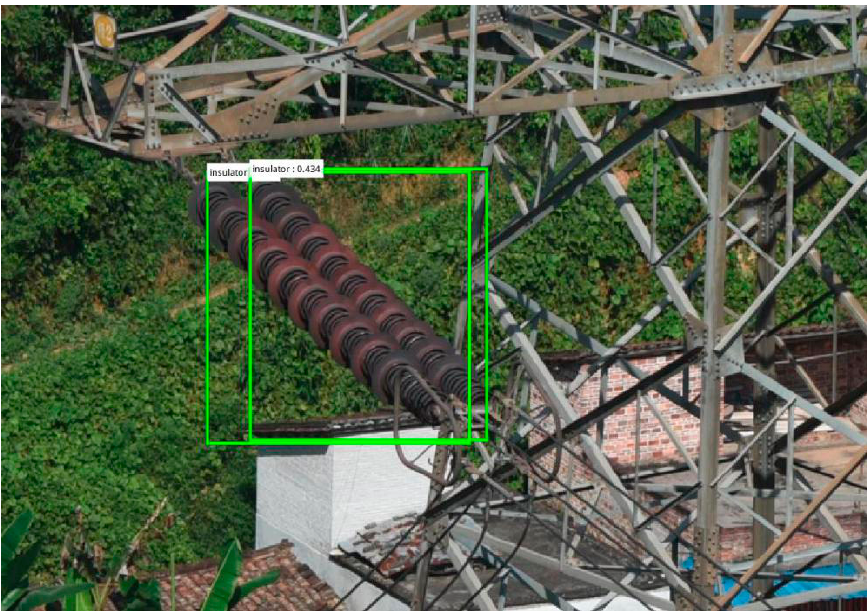
Figure 11. Results of eliminating redundant boxes with improved NMS.